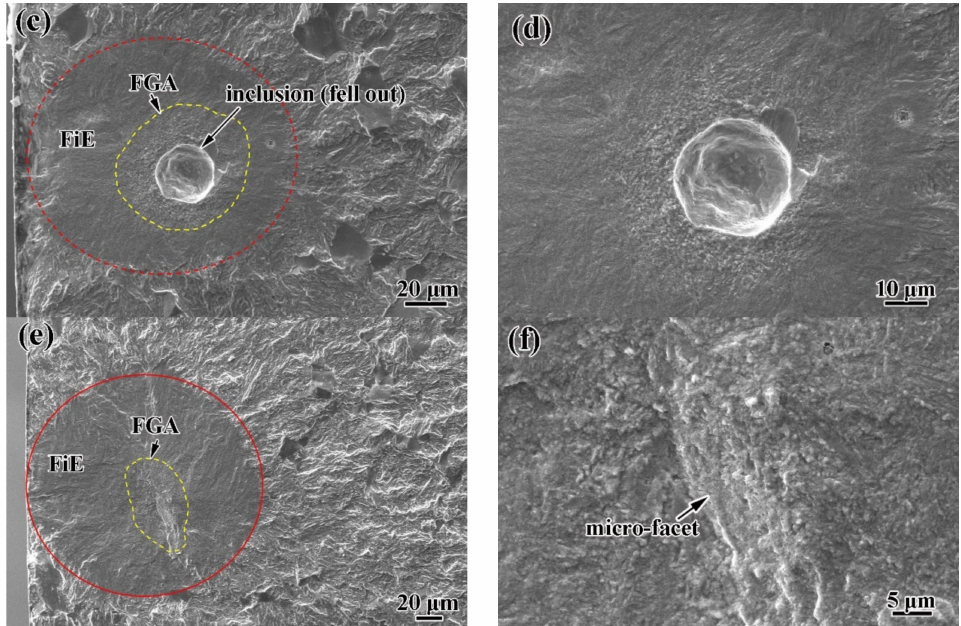
Figure 4. SEM images of fatigue crack initiation morphologies; ( a ): UBAT sample, surface inclusion ( σ a = 824 MPa, N f = 1.16 × 10 6 cycles); ( b ): BQ&P sample, surface inclusion ( σ a = 902 MPa, N f = 3.82 × 10 5 cycles); ( c ): BQ&P sample, interior inclusion ( σ a = 843 MPa, N enlarged window of ( c ); ( e ): UBAT sample, NIICI ( σ a = 726 MPa, N f = 5.28 × 10 6 cycles); ( f ) The enlarged window of ( e ); FiE: fish-eye, FGA: fine granular area.